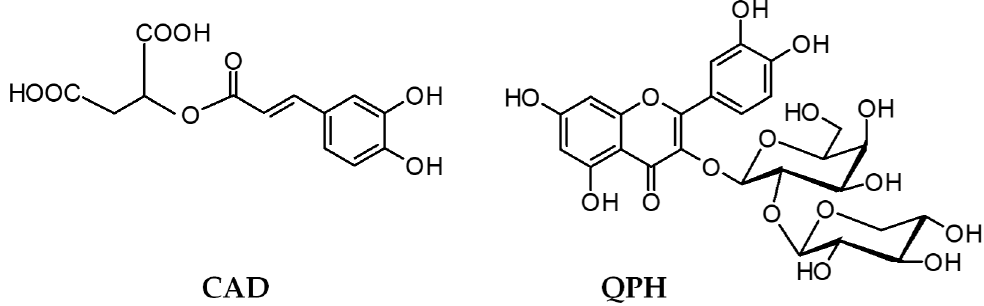
Figure 2. Structures of the isolated phenolics—caffeoylmalic acid (CAD) and quercetin 3- O -(2″- O -β- D -xylopyranosyl)-β- D -galactopyranoside